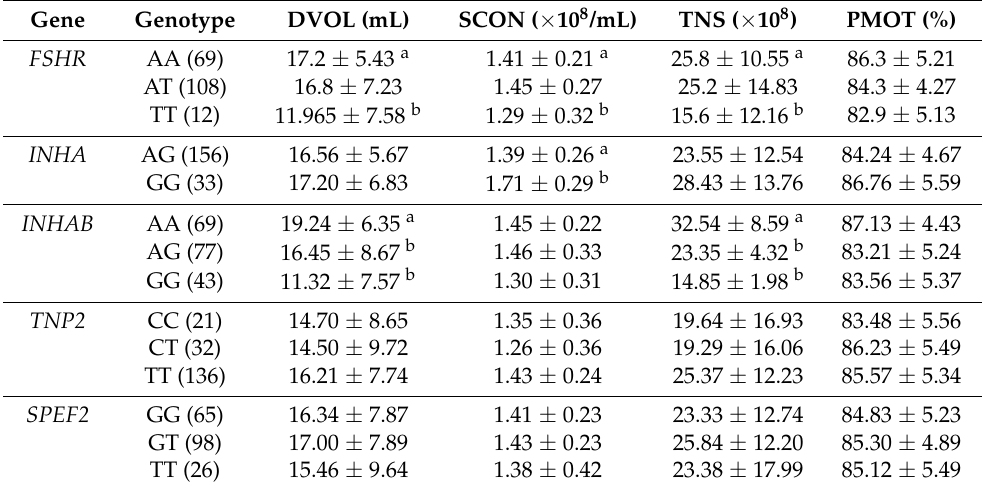
Table 4. Distribution of semen quality traits by genotypes FSHR , INHA , INHAB , TNP2 and SPEF2 genes genotypes in Russian Holstein